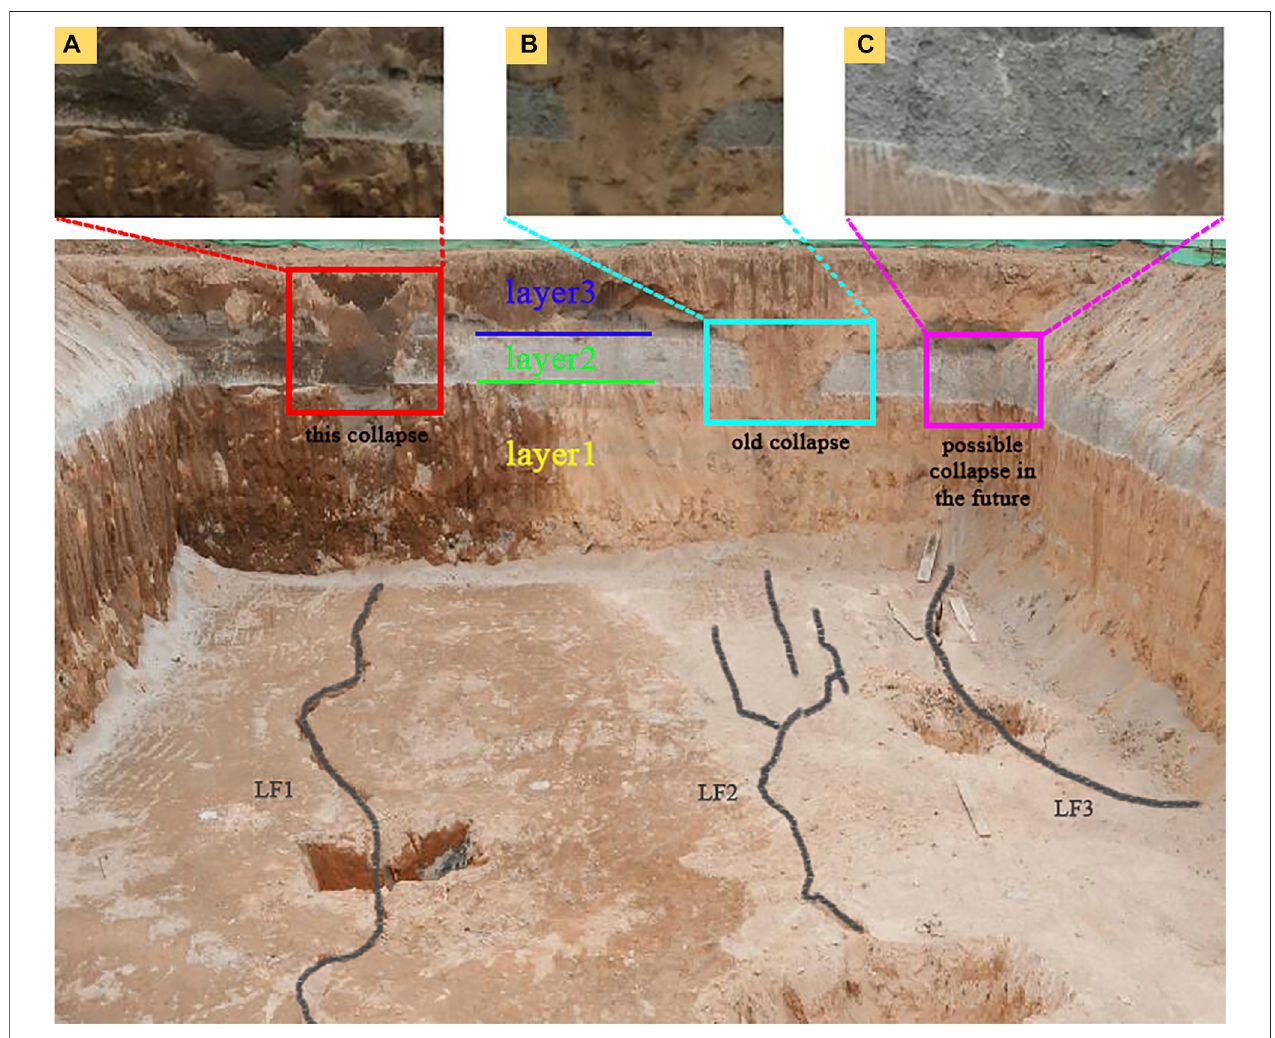
FIGURE 2 | Location relation of overlying soil collapse and bedrock cracks in exploratory trench nearby ground fi ssure DK76. (A) Location of “ this collapse ” ; (B) position of “ old collapse ” ; (C) position of “ possible collapse in the future. ”